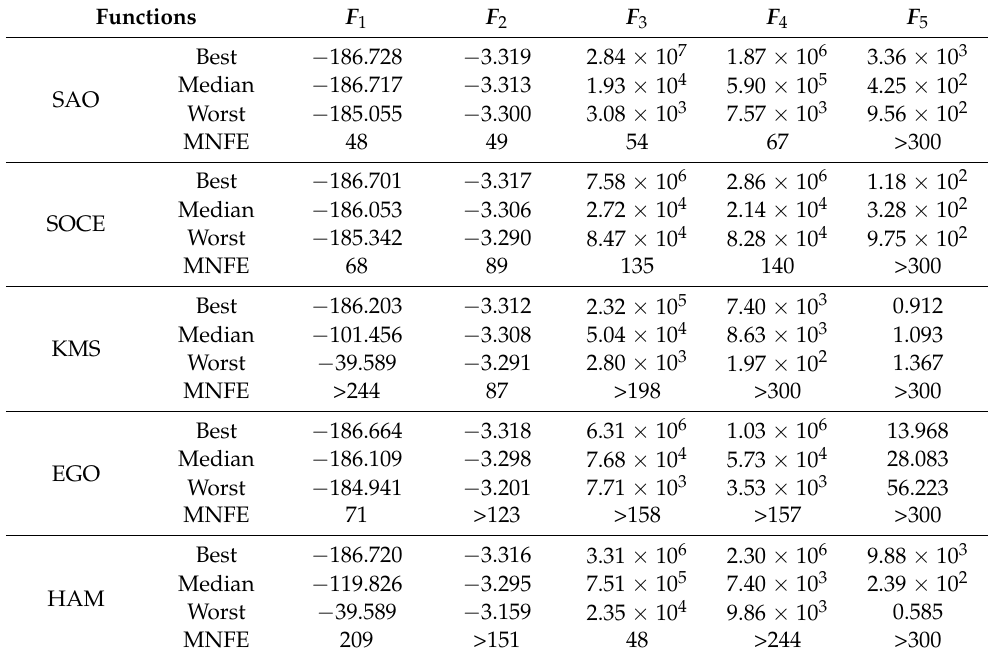
Table 4. Numerical results obtained by the surrogate-based optimization algorithms.